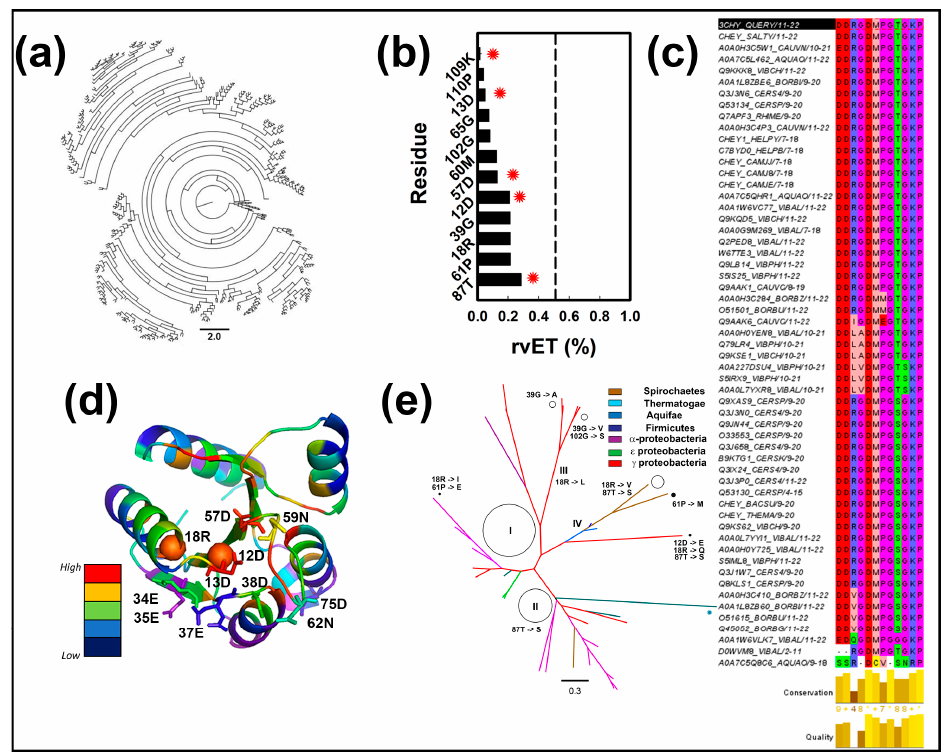
Figure 5. The evolutionary importance of ALPF 18R in CheY evolution. ( a ) The phylogenetic tree for E. coli CheY. Based on 443 sequences used by EV-Trace. Scale bar = 2.0. ( b ) Top (10%) residue positions. The E. coli CheY residue positions were ranked by rv.ET score. Asterisks denote residues known previously to be important for chemotaxis. ( c ). Residue conservation of the top rv.ET ranked positions. From an MSA of 56 sequences from 12 distinct species. ( d ) The 3D CheY structure color- coded by ev.ET score. The residues oxidized by XFMS are labelled (stick sidechains). Spheres mark the residues 12D and 18R (spheres) important for CheY evolution under selection for chemotaxis. ( e ) The phylogenetic tree constructed from the MSA of CheY chemotaxis proteins. 56 CheY sequences. The non-polar 18R substitutions localize at the internal tree nodes. Roman numerals denote major branches. Circle diameter = branch size. Note difference in scale with the EV-Trace tree ( a ).